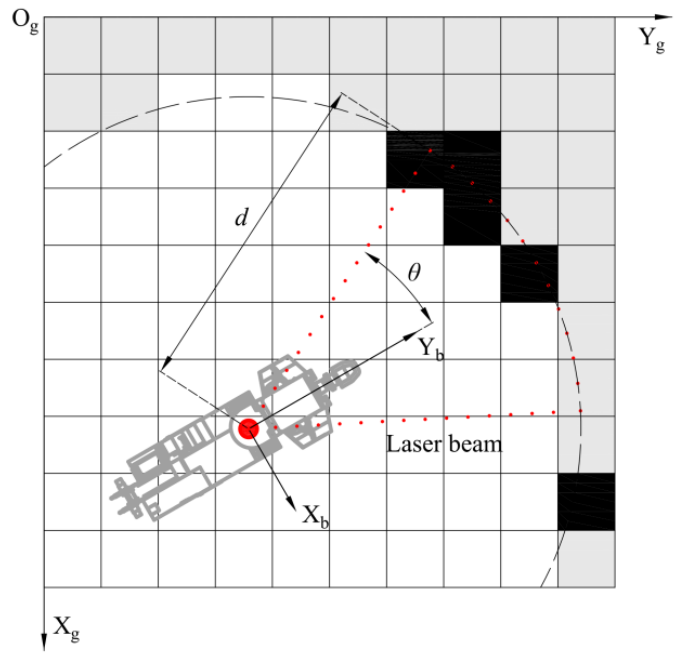
Figure 8. Construction principle of occupied grid map.